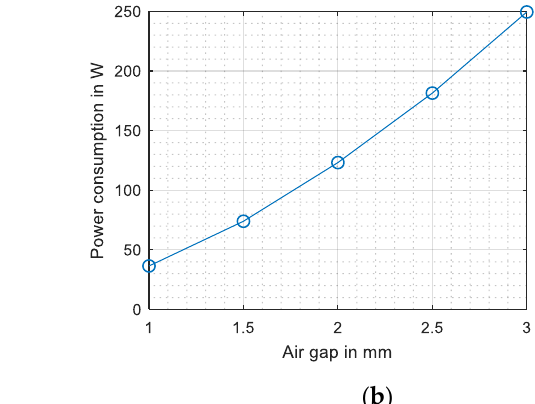
Figure 12. ( a ) Electric magnet assembled with the cover plate; ( b ) Power requirement as a function of air gap for a rotor weight compensation of 1350 N.